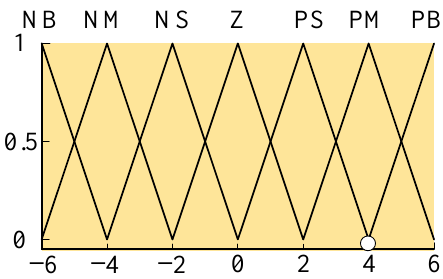
Figure 8. Input and output membership functions.